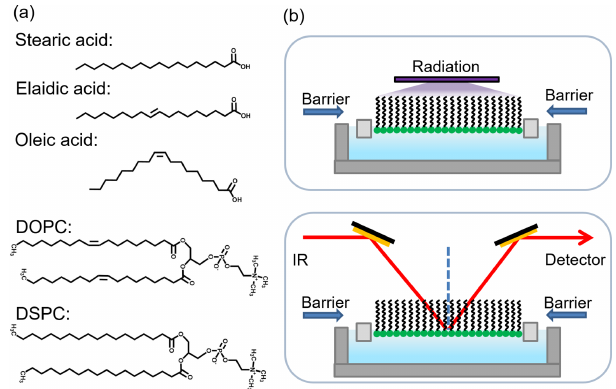
Figure 1. (a) Molecular structures of stearic acid, elaidic acid, oleic acid, DOPC, and DSPC. (b) Schematic representation of IRRAS and the irradiation